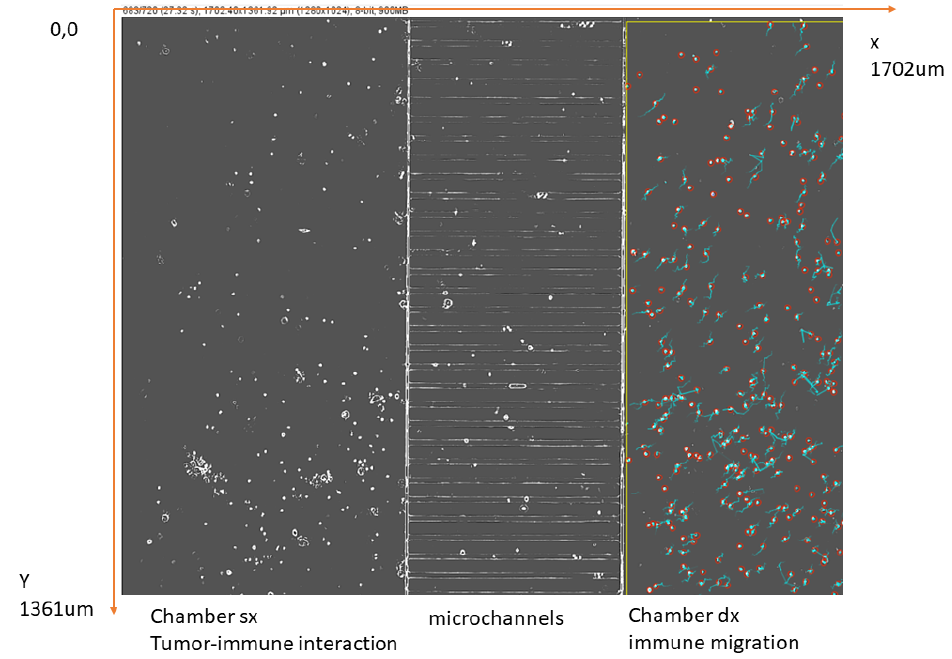
Figure 3. Video frame representing the microfluidic chip area under observation. The migration of leukocytes from the right to the left chamber is traced. Credit: Crop of an image in Vacchelli et al. [2] edited by